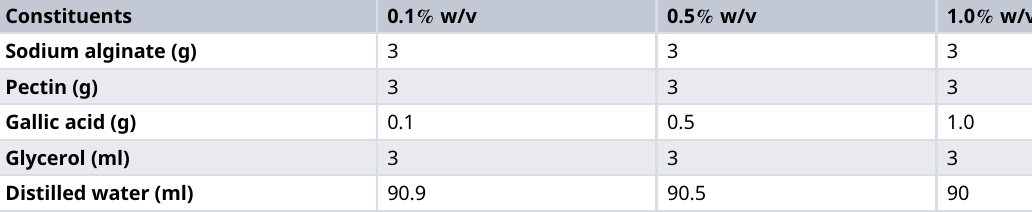
Table 2. Composition of sodium alginate hydrocolloid films containing various strengths of gallic acid (GA).